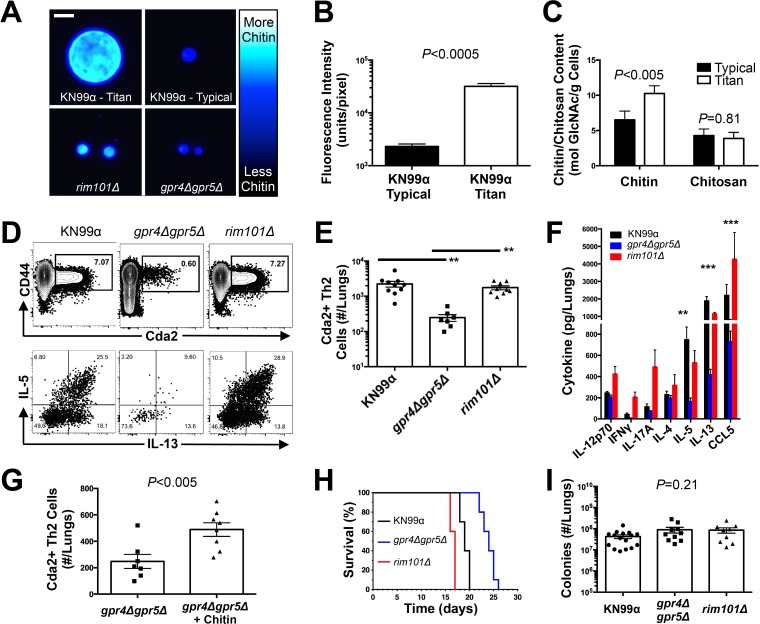

C. neoformans Chitin Correlates with Type-2 Helper T Cell Response and Subsequent Disease.(A&B) Cryptococcal cells isolated from lungs at 14 days post-infection and stained with Calcofluor White. Cells were either imaged with epifluorescence microscopy (A) or analyzed by flow cytometry with fluorescence intensity calculated per pixel to determine chitin density within the cell wall (B). (C) Total chitin and chitosan content normalized to dry weight of cryptococccal cells. (D) Flow cytometry plots of CD4+, Foxp3-, CD44+ Cda2+ Th cells expressing Th2 cytokines, IL-5 & IL-13, at 14 days post-infection and (E) the quantification of these plots. (F) Cytokines from lung homogenates of mice 14 days post-infection. (G) IL-5+ IL-13+ antigen-specific Th2 cells from lungs of mice 14 days post-infection without and with intranasal chitin particle treatment. (H) P-value represents log-rank test comparing each survival curve with 10 mice per group to: gpr4Δgpr5Δ vs. KN99α, P<0.0005; gpr4Δgpr5Δ vs. rim101Δ, P<0.0005; KN99α vs. rim101Δ, P<0.0005. (I) Fungal burden in the lungs at 14 days post-infection. Data are presented as the mean +/- standard error with at least 2 independent experiments per group. ** = P < 0.005, *** = P < 0.0005 by Mann-Whitney U or Kruskal Wallis ANOVA. Cda = chitin deacetylase, CCL = chemokine ligand, GlcNAc = N-acetylglucosamine, IFN = interferon, IL = interleukin.